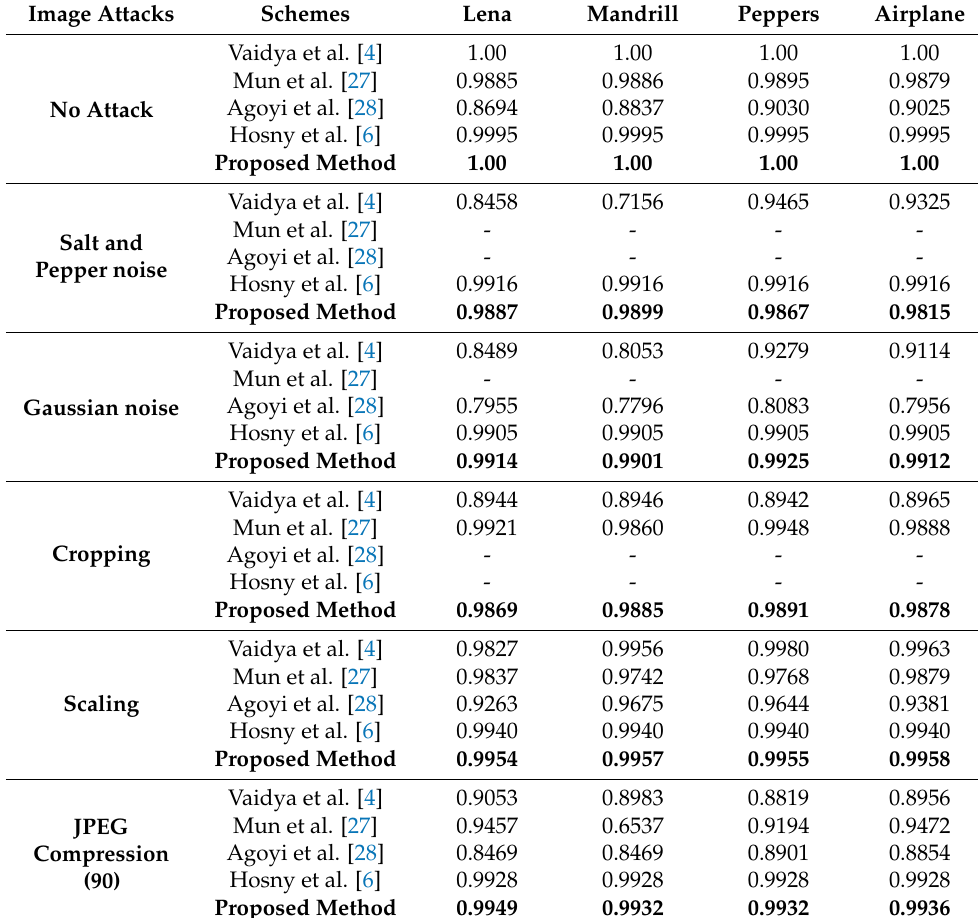
Table 5. Comparison of NCC values with related watermarking